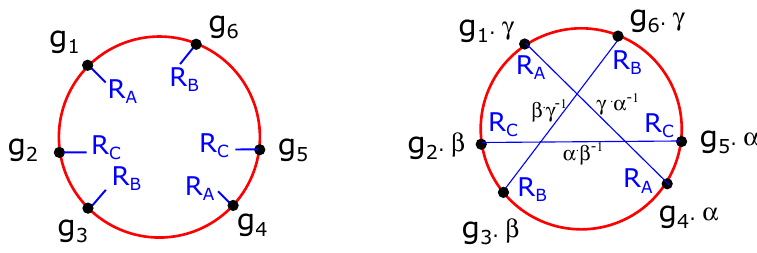
Figure 17 . Left: particle-on-a-group evaluation. Right: choice of group elements that agrees with the bulk BF